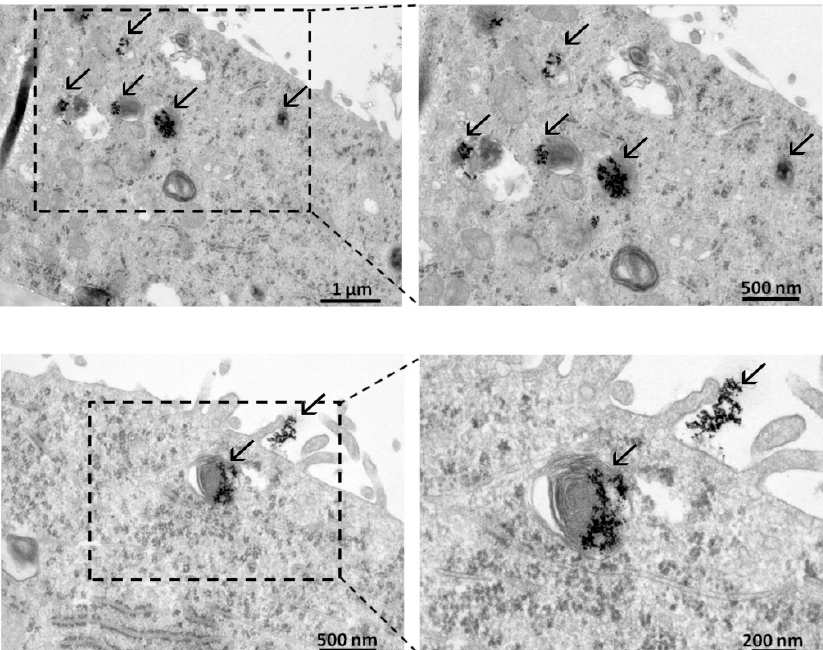
Figure 2. Internalization of AuNPs by A549 adenocarcinoma cells. AuNPs (indicated by arrows) were detected by TEM image analysis on the surface of A549 cells and inside the cytoplasm as well, mostly in multilamellar bodies.